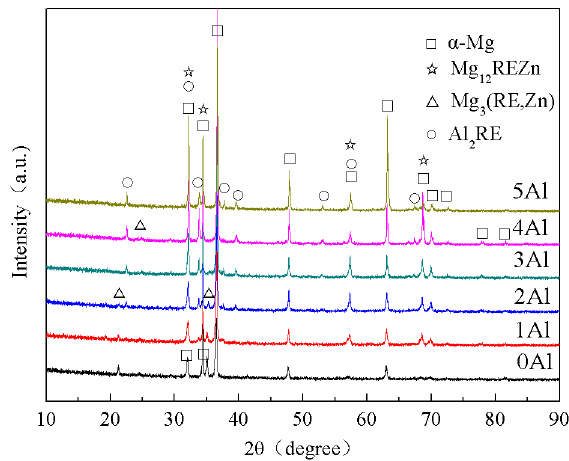
Figure 1. XRD patterns of as-cast Mg-11Gd-2Y-1Zn-xAl alloys.